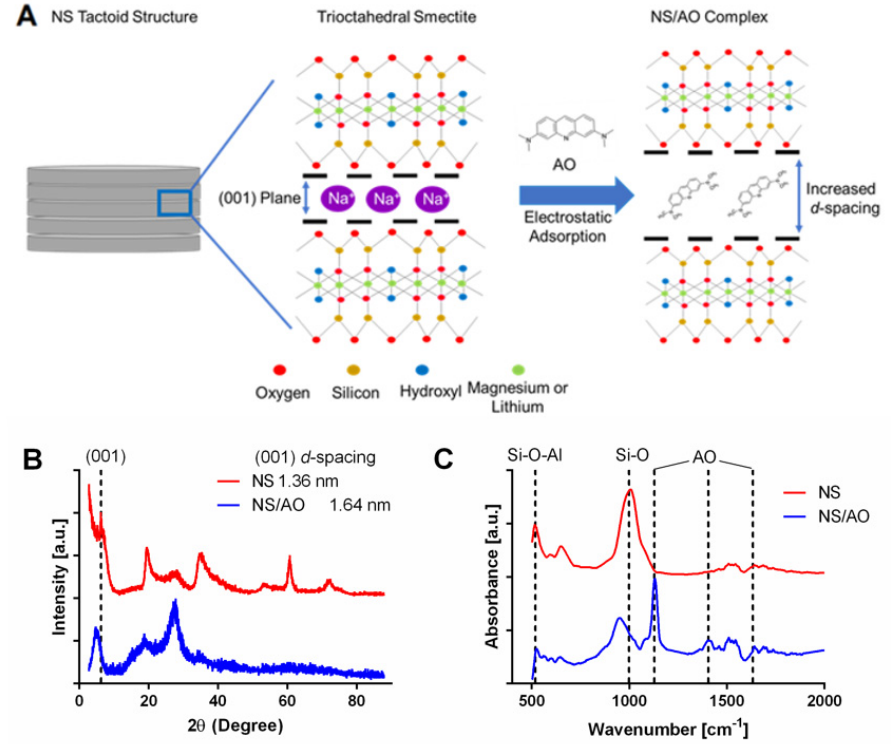
Figure 1. Intercalation of AO between NS particle layers. ( A ) Schematic of intercalation of AO into (001) planes of NS particles, resulting in increased d -spacing. ( B ) XRD patterns of NS particles and NS/AO complexes. The leftward shift of the NS/AO 2 θ peak at the (001) plane indicates increase in d -spacing between NS layers. ( C ) FTIR-ATR spectra of NS particles and NS/AO complexes, indicating interaction with NS silicate groups. Vertical dash lines indicate bands at 533, 991, 1127, 1401, and 1633 cm − 1 .